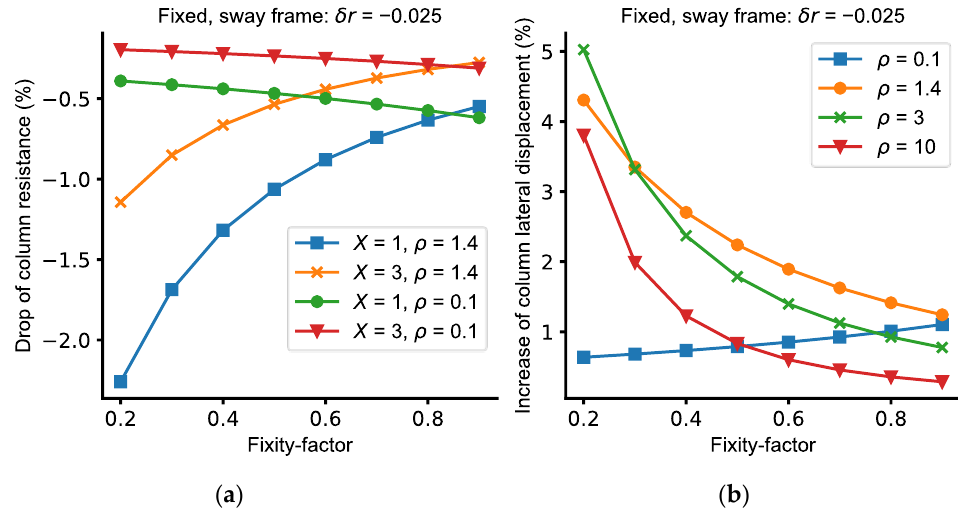
Figure 8. Case with fixed base: ( a ) Column resistance dropping, ( b ) Increase of column top lateral displacement.